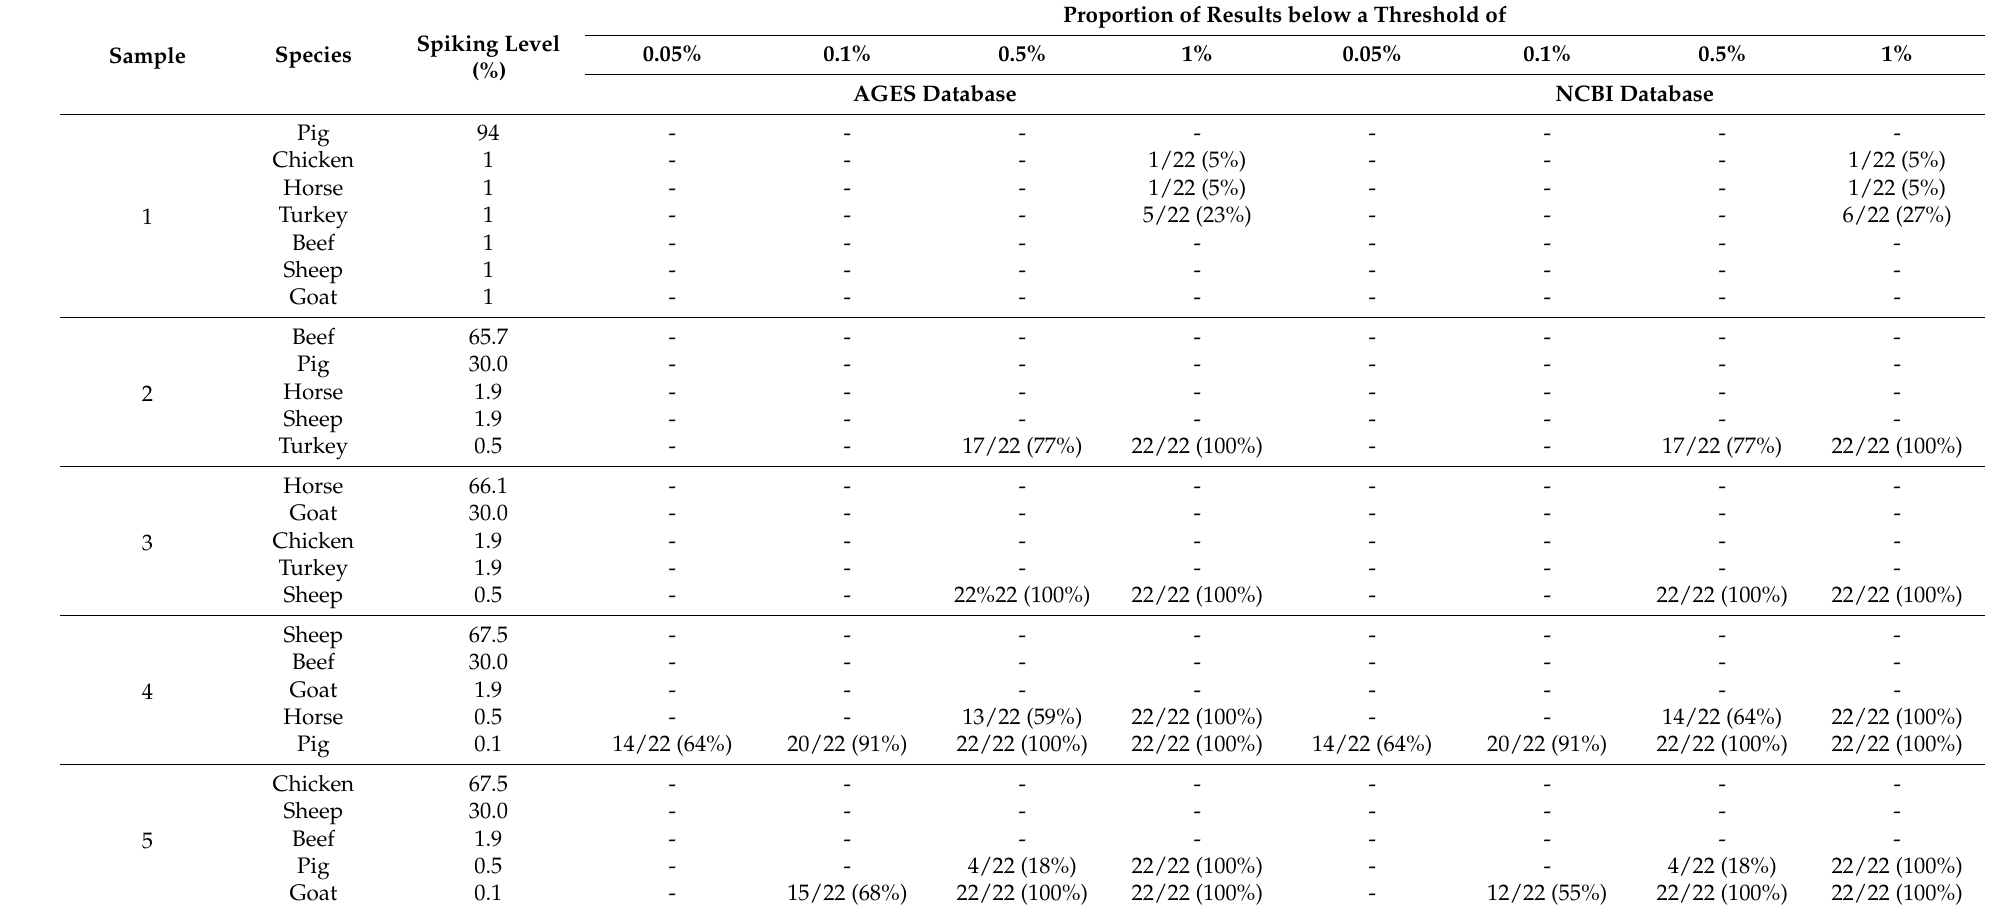
Table 7. Proportion of results below a thresholds of 0.05%, 0.1%, 0.5%, and